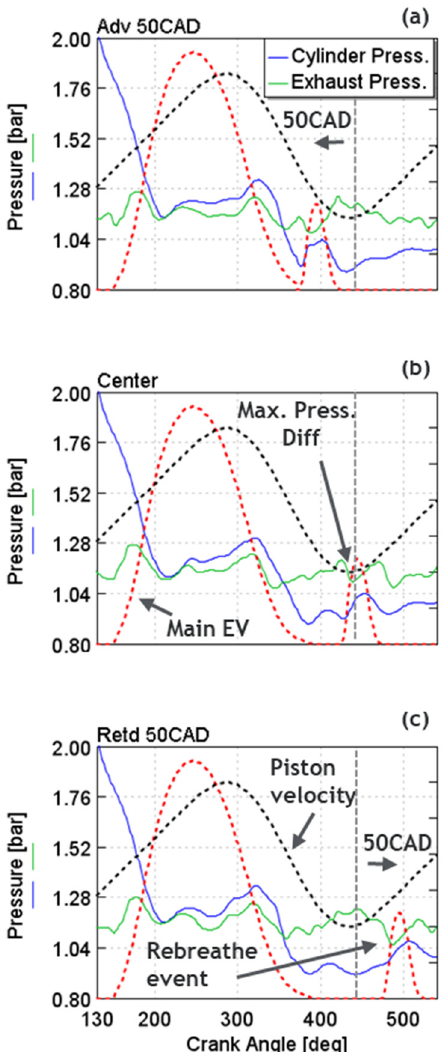
Figure 16. The cylinder and the exhaust pressure traces for the ExReb locations of ( a ) advanced 50 CAD, ( b ) center, and ( c ) retarded 50 CAD for Tivc 404 K at B10.